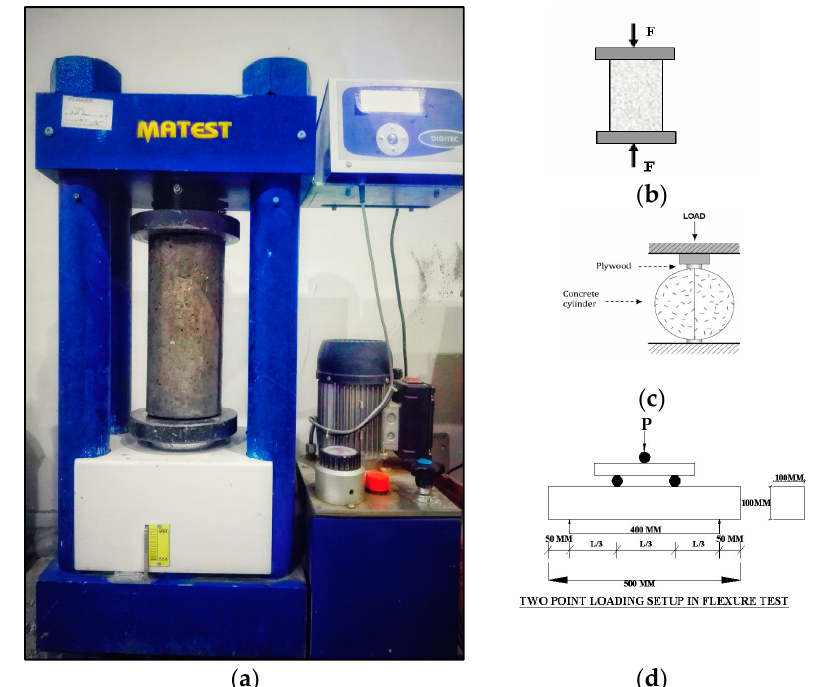
Figure 3. ( a ) Compression machine, ( b ) compressive strength, ( c ) split tensile, ( d ) flexural strength test mechanism. test